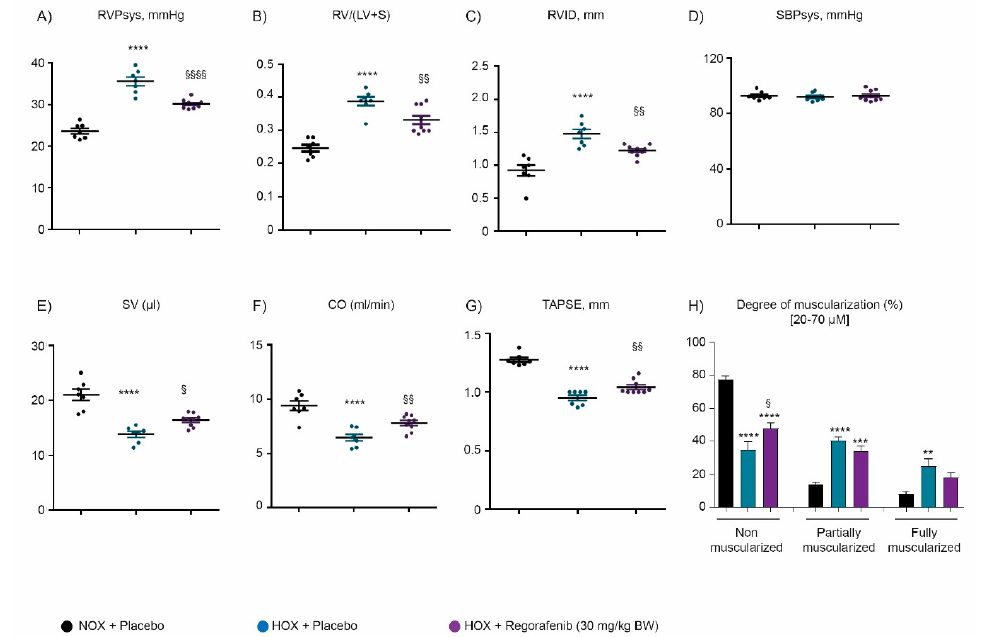
Figure 3. Effect of regorafenib on cardio-pulmonary functions in chronic hypoxia (HOX)-induced pulmonary hypertension. ( A ) Right ventricular systolic pressure (RVSP, mmHg). ( B ) Fulton index measured as the ratio of RV to LV plus septum (RV/LV + S). ( C ) Right ventricle internal diameter (RVID, mm). ( D ) Systemic arterial pressure (SBPsys, mmHg). ( E ) Stroke volume (SV, µL). ( F ) Cardiac output (CO, mL/min). ( G ) Tricuspid annular plane systolic excursion (TAPSE, mm) and ( H ) degree of muscularization was measured as a percentage of small pulmonary arteries (20–70 µM) characterized by non-muscularized, partially muscularized, and fully muscularized in NOX + placebo ( n = 7), HOX + placebo ( n = 7), and HOX mice treated with regorafenib ( n = 9). **** p < 0.0001, *** p < 0.001, and ** p < 0.01 versus NOX + placebo; §§§§ p < 0.0001, §§ p < 0.01 and § p < 0.05 versus HOX + placebo. Data represent the mean ± SEM.